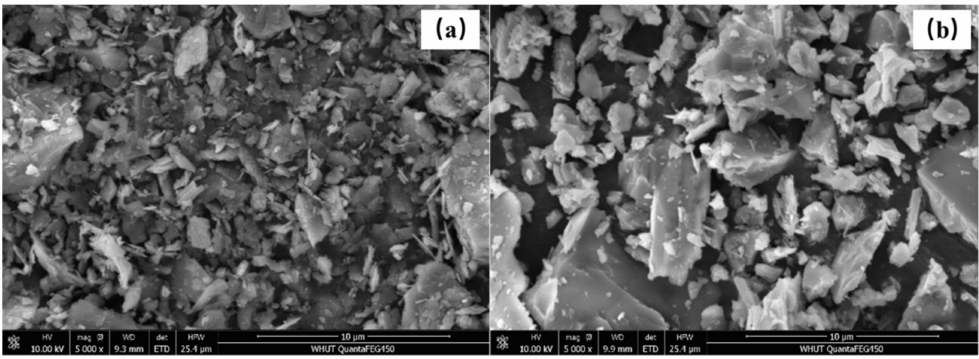
Figure 1. The SEM images of particle morphology for ( a ) iron ore tailing (IOT) and ( b ) cement.